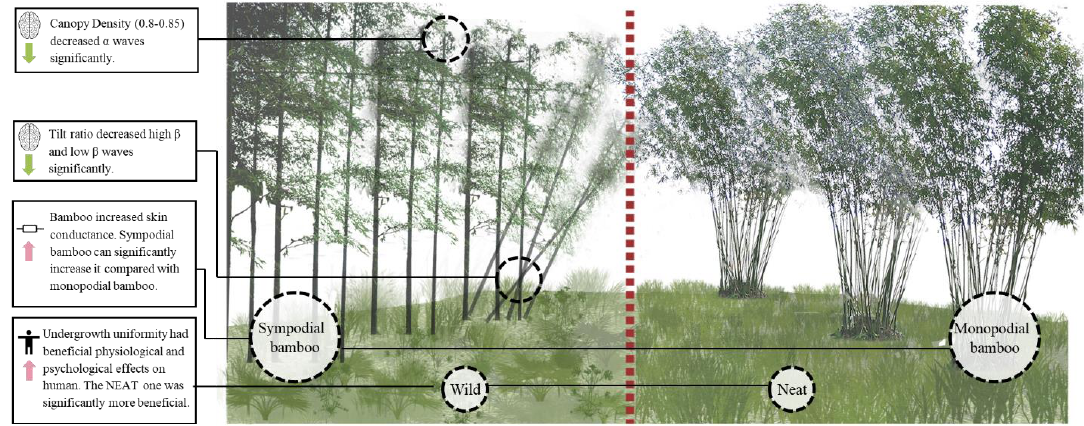
Figure 7. Psychophysiological effects of urban bamboo forest videos showing different structures.